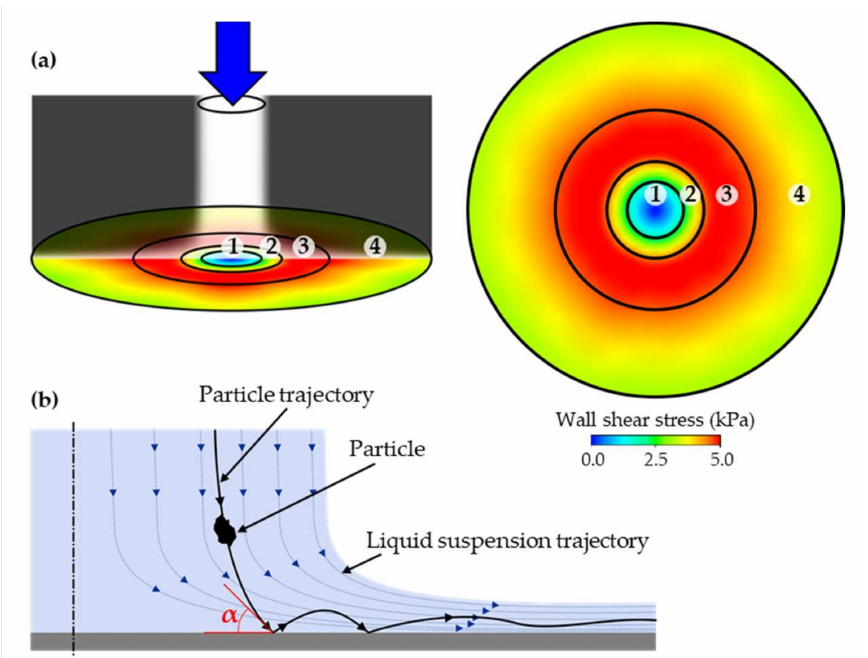
Figure 18. ( a ) Division of the workpiece surface according to the wall shear stress and ( b ) a sketch of typical fluid and particle trajectory inside the suspension